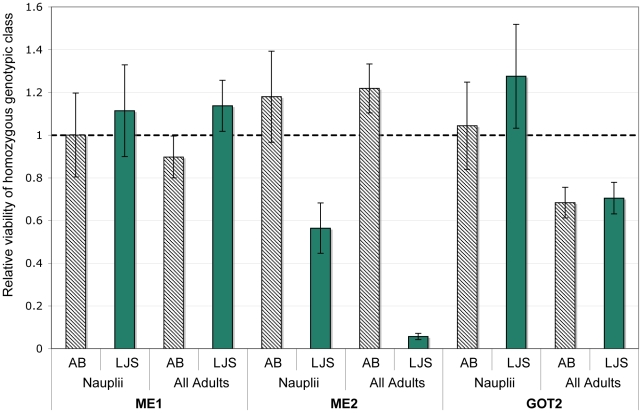
Relative viability of the ME1, ME2, and GOT2 markers in the ABf x LJSm cross.Relative viability of each of the three markers in the ME1, ME2, and GOT2 genes are shown from F2 adult hybrids from the cross of the AB and LJS populations of T. californicus. The relative viability of the two homozygous genotypic classes in comparison to the heterozygous genotypic class is given with standard deviations indicated by error bars as described for Figure 2. AB indicates the AB/AB homozygous genotypic class while LJS indicates the LJS/LJS genotypic class. Full numerical results including results from the reciprocal cross are available in Table S2.